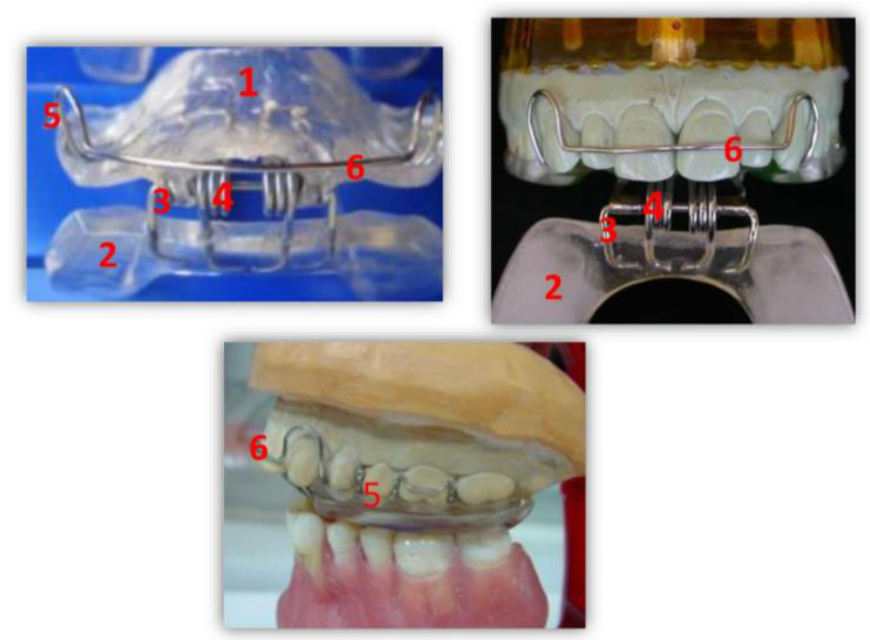
Figure 2. RA.DI.CA. splint and its components. The upper plate has two surfaces. The inner one, also called the “occlusal/palatal” surface, adapts to the masticatory surfaces of the upper teeth and to the anterior 2/3 of the palatal vault. The outer surface is smooth and faces the lower plate. Two Adams clasps are placed on the right and left first molars and the ball clasps are placed in the interdental space of the right and left first and second premolars. The upper plate plays a stabilizing role, having a double mucous and a dental